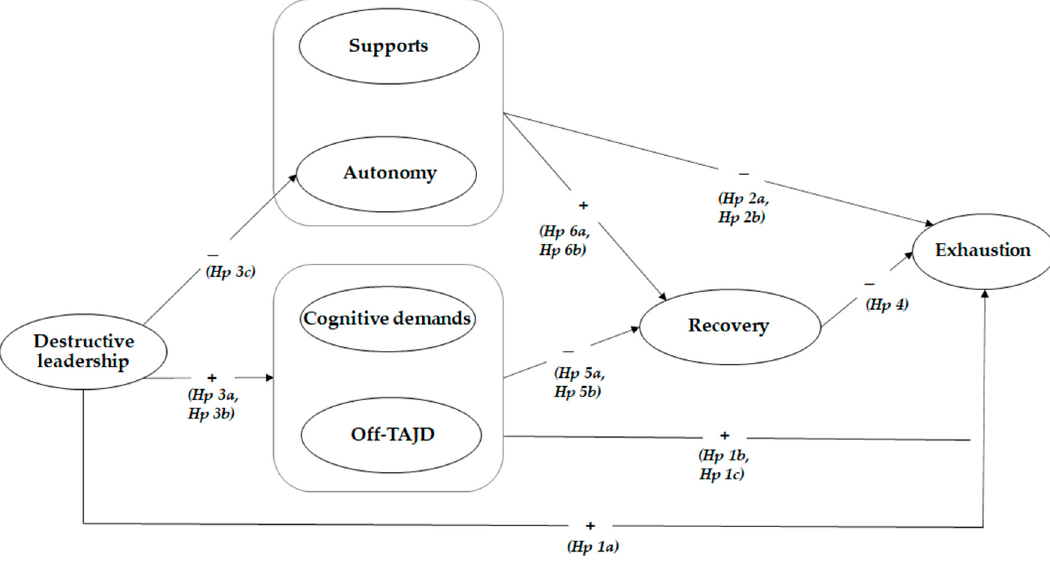
Figure 1. The hypothesized model. Note . Hypothesis (Hp). O ff -work-hours technology-assisted job demands (O ff